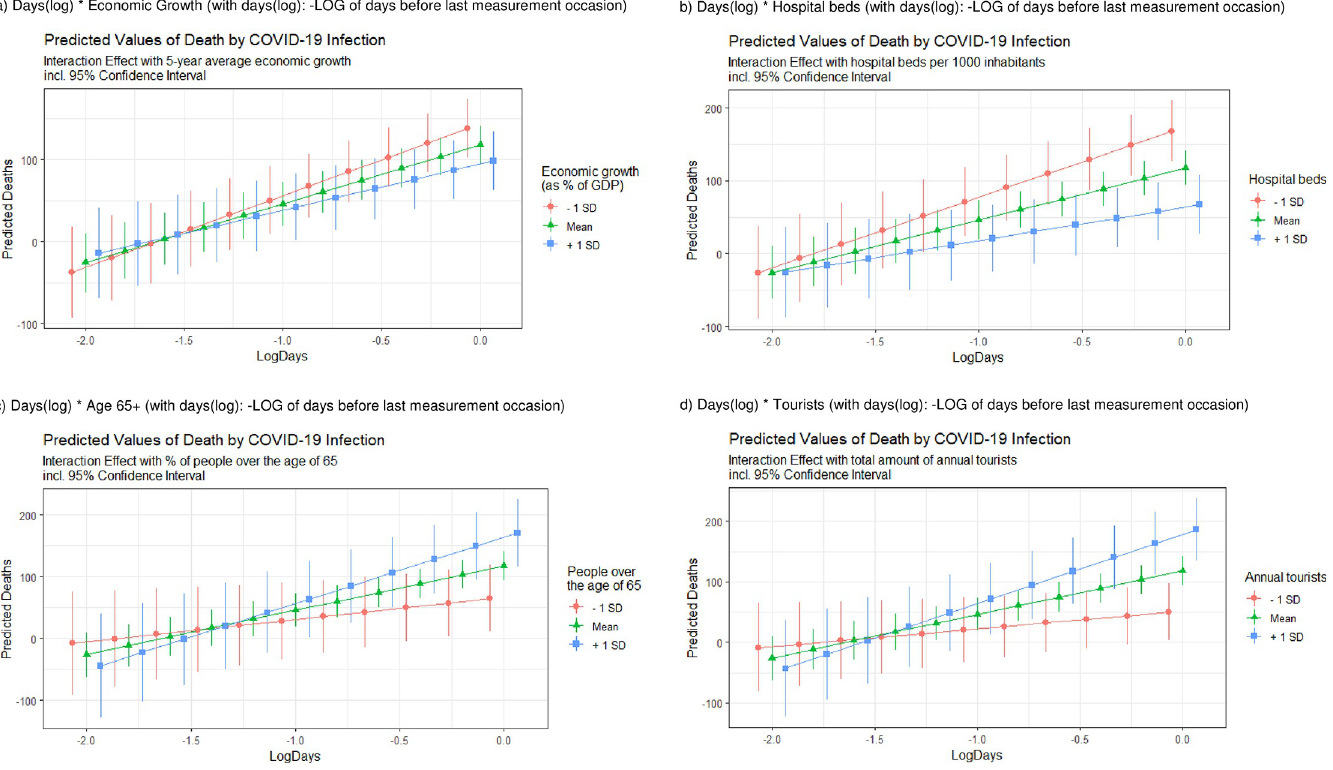
Fig 3. Visualization of four moderator effects (line positions were dodged for better visibility and to avoid over plotting). All coefficients represent the value for the exact same respective log-day). a) Days(log) � Economic Growth (with days(log): -LOG of days before last measurement occasion). b) Days(log) � Hospital beds (with days(log): -LOG of days before last measurement occasion). c) Days(log) � Age 65+ (with days(log): -LOG of days before last measurement occasion). d) Days(log) � Tourists (with days(log): -LOG of days before last measurement occasion).